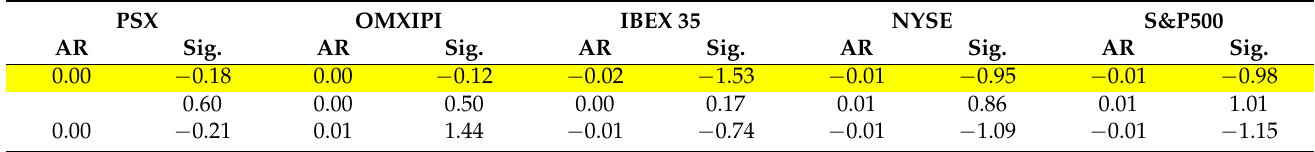
Table A16. Abnormal returns of the (0, +2) event window (Prime Minister of Iceland announced his